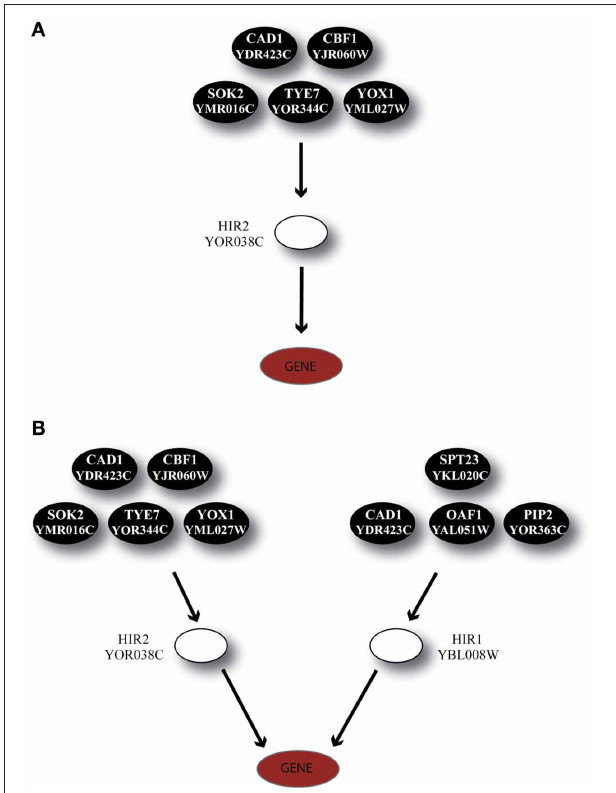
FIGURE 7 | Regulatory cascades containing the TF HIR2 as the GRAM-identified regulator. (A) Regulatory cascade where only HIR2 is considered as regulator. (B) Regulatory cascade where HIR2 and HIR1 are considered as regulators of the target